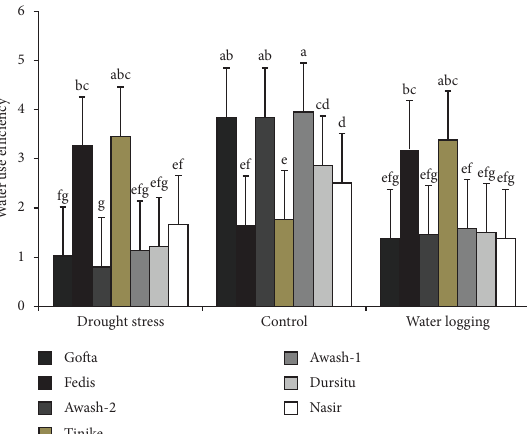
Figure 2: Interaction efect of common bean varieties and soil irrigation interval on water use efciency under Lath House, 2020.